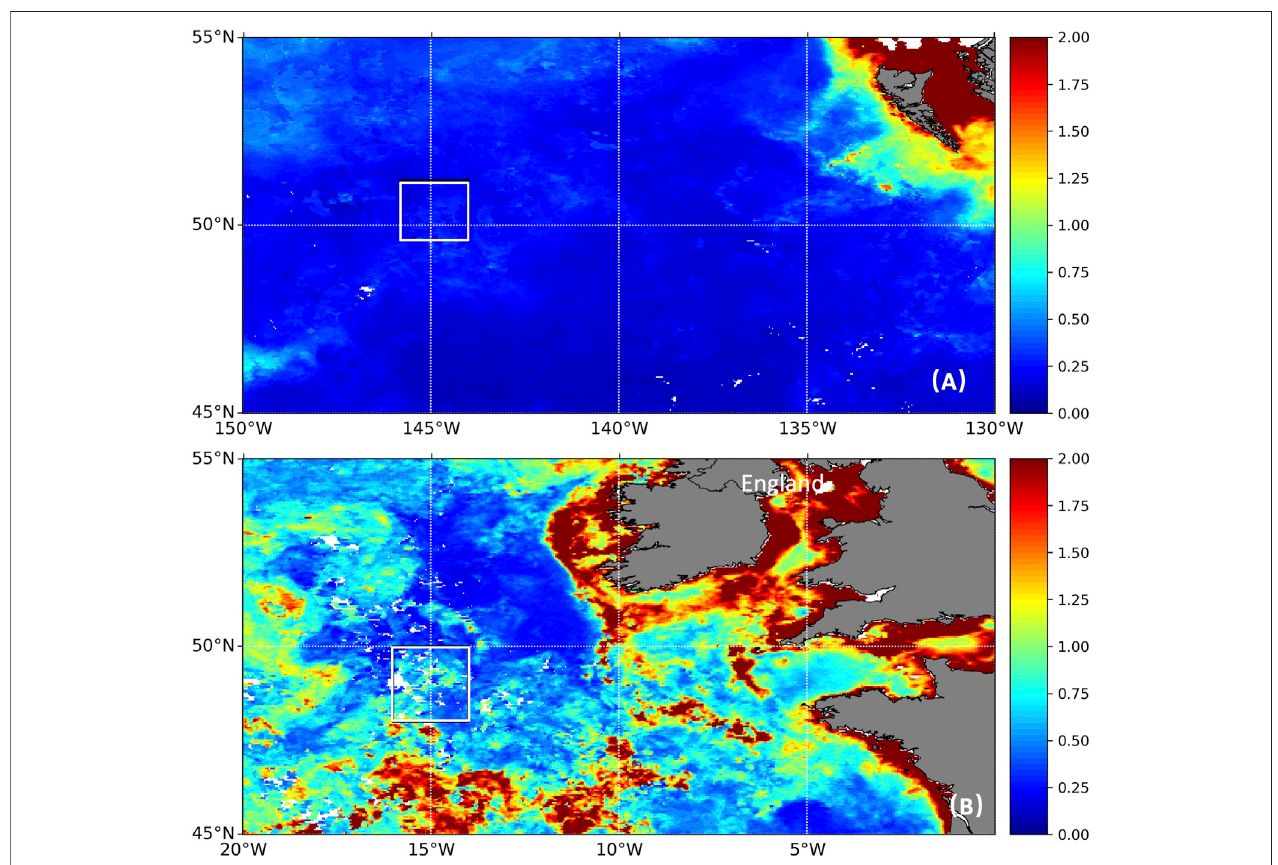
FIGURE1| Boundary(whiterectangles)ofthe (A) NPO-18and (B) NAO-21sitesoverlaidonmonthlymeanchlorophyllconcentrationmaps(mg m − 3 )derivedfrom the MODIS-Aqua